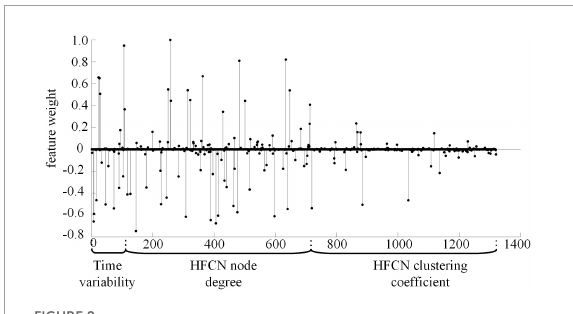
FIGURE8 The normalized classification weights of all features ( U = 600).